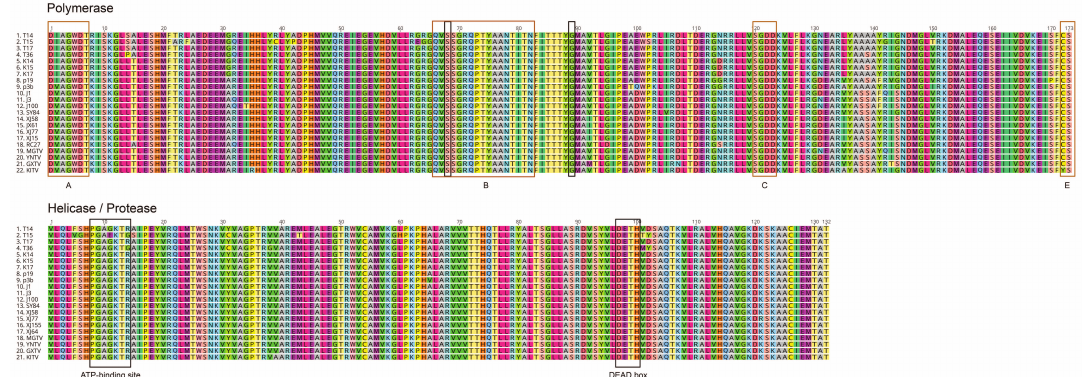
Figure 3. Topography of retinal ganglion cell loss in the injured and contralateral retinas. Top, drawings representing both eyes, their optic nerves, and the lesion site. Figure 5. Alignment of the JMTV RNA-dependent, RNA polymerase and helicase / protease motifs, Left: ONC performed at 2 mm. Right: ONC performed at 0.5 mm. Blue eyes: contralateral. Red: injured. Below: neighbour maps illustrating the topography of identified on viral genomic segments 1 and 3. The figures cover 576–748 and 341–472 residues of surviving RGCs from 3 to 90 days in representative retinas from each group. These neighbour maps illustrate the number of RGCs around a given RGC in a radius of the mature nonstructural protein 1 (NSP1) and NSP2 proteins, respectively. Regions and residues 0.200 mm with a colour scale (top, second from the left panel) from 0–25 neighbours (purple) to > 201 neighbours (dark red). The bottom left of each map shows the number of RGCs counted in the original retina. d: days post-lesion; S: superior; N: nasal. corresponding to the conserved motifs of the flavivirus replicase (A, B, C, E) (brown) and with functional significance (black) are indicated. Information on virus strains used for comparison are provided in Supplementary Table